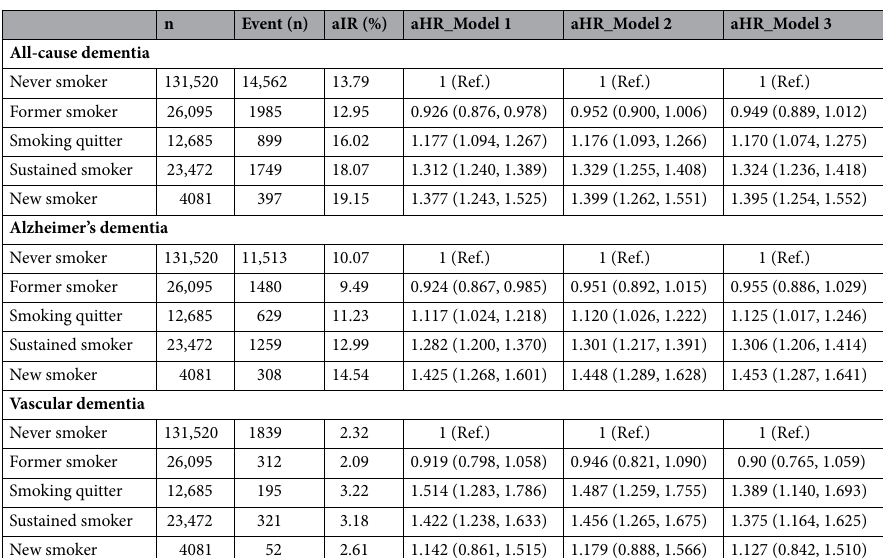
Table 2. Risk for All-cause dementia, AD dementia and VaD according to the smoking habit change. HR hazard ratio, aHR adjusted hazard ratio, aIR adjusted incidence rate, PY person-years. Model 1: age and sex- adjusted, Model 2: age, sex, alcohol consumption, regular physical activity, low-income, diabetes, hypertension, lipid and chronic kidney disease, Model 3: Model 2+ Cigarette pack years.